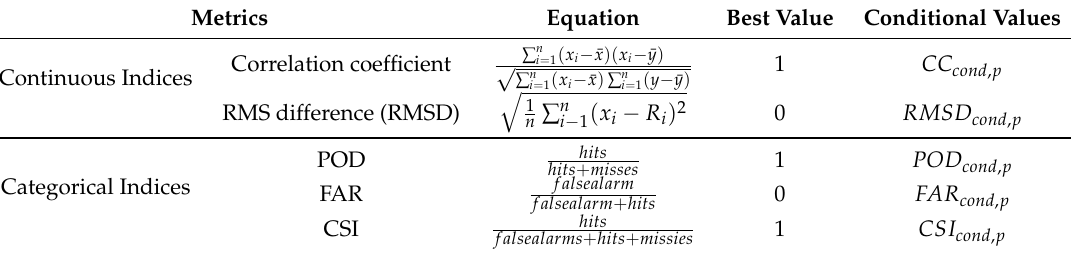
Table 2. Continuous and categorical indices used in this